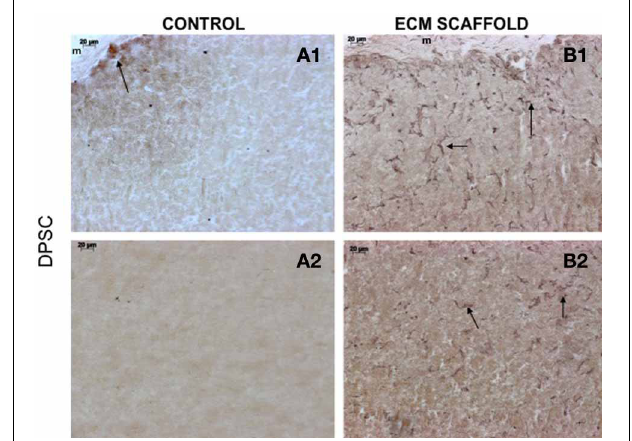
FIGURE 9 | DPSCs in ECM scaffold: von Willebrand factor (VWF) immunohistochemistry. The micrographs are representative images of VWF stained explant sections containing DPSCs in control (A) and pulp ECM (B) scaffolds. In all the images, 1 and 2 nomenclature indicates micrographs that show expression of VWF in the periphery (1) and within (2) the respective scaffolds. The arrows in the images point to positively stained endothelial cells and capillary networks. Note the absence of positive staining in the interior of the control scaffolds containing DPSCs (A2) , and positive staining in the periphery of the control scaffolds (A1) .